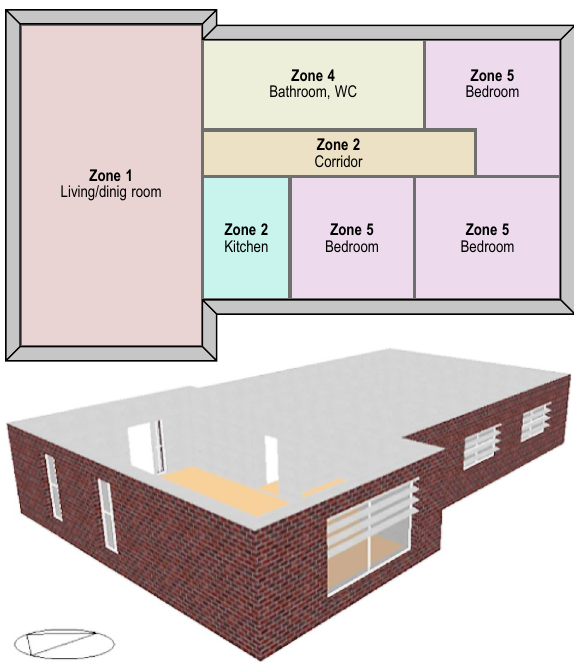
Fig. 2. Plan of the low energy house (the research object)